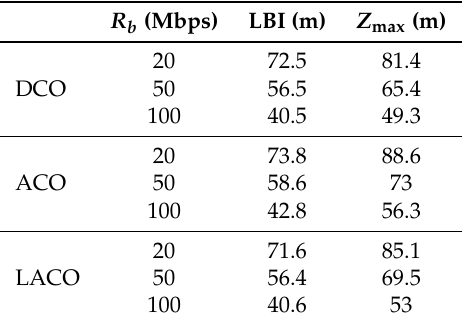
Figure 8. BER performance as a function of distance for DCO-, ACO-, and LACO-OFDM. P Tx,e = 50mW, N = 1024; N CP = 9, 20, and 28, for R b = 20, 50, and 100Mbps, respectively. Table 3. LBI and maximum attainable range for DCO, ACO, an LACO-OFDM transmission schemes according to Figure8; P Tx,e = 50mW, BER = 10 − 3 , η ≈